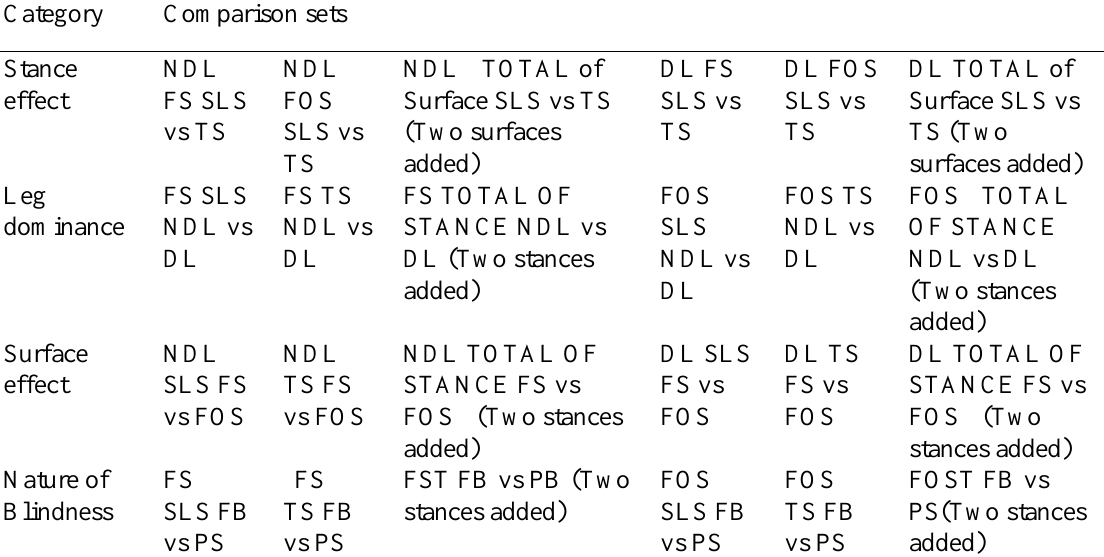
Table 2. Comparison sets and the categories for the Wilcoxon-Mann-Whitney Test and Kendall's Tau.